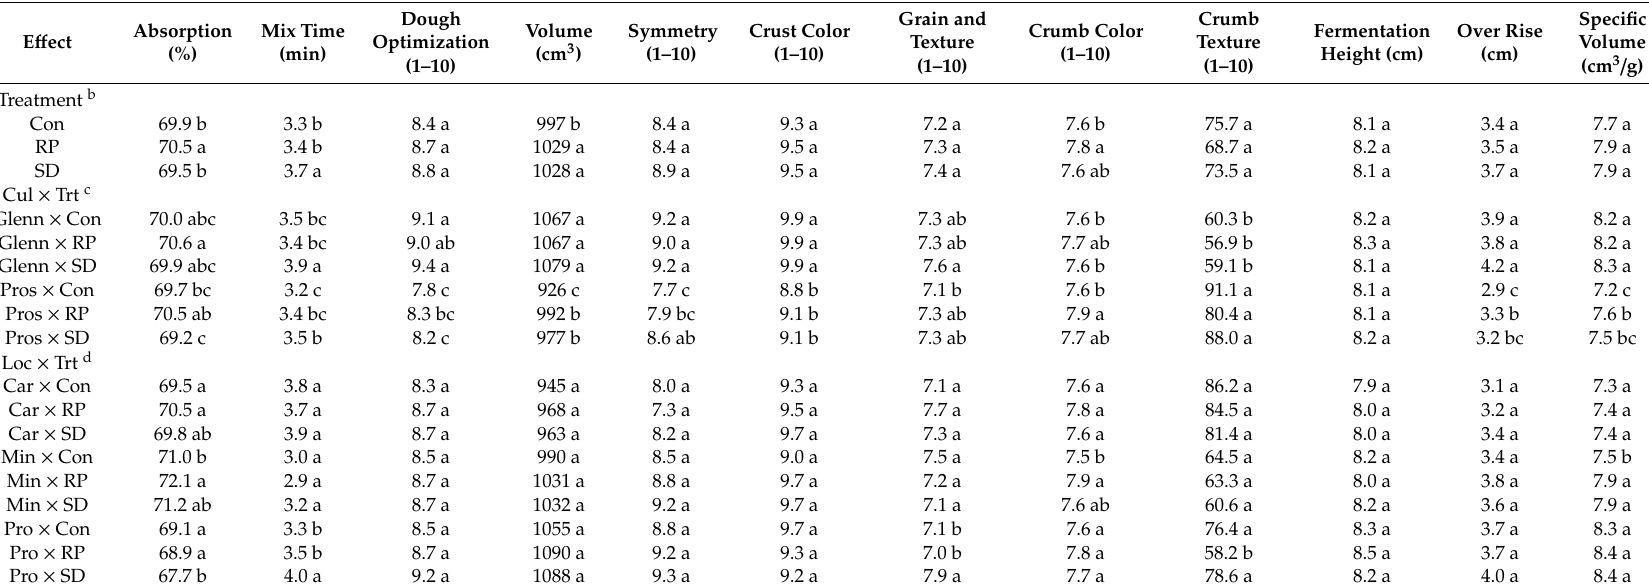
Table 3. Baking quality parameters as a ff ected by treatment and the interaction between treatment and other factors a